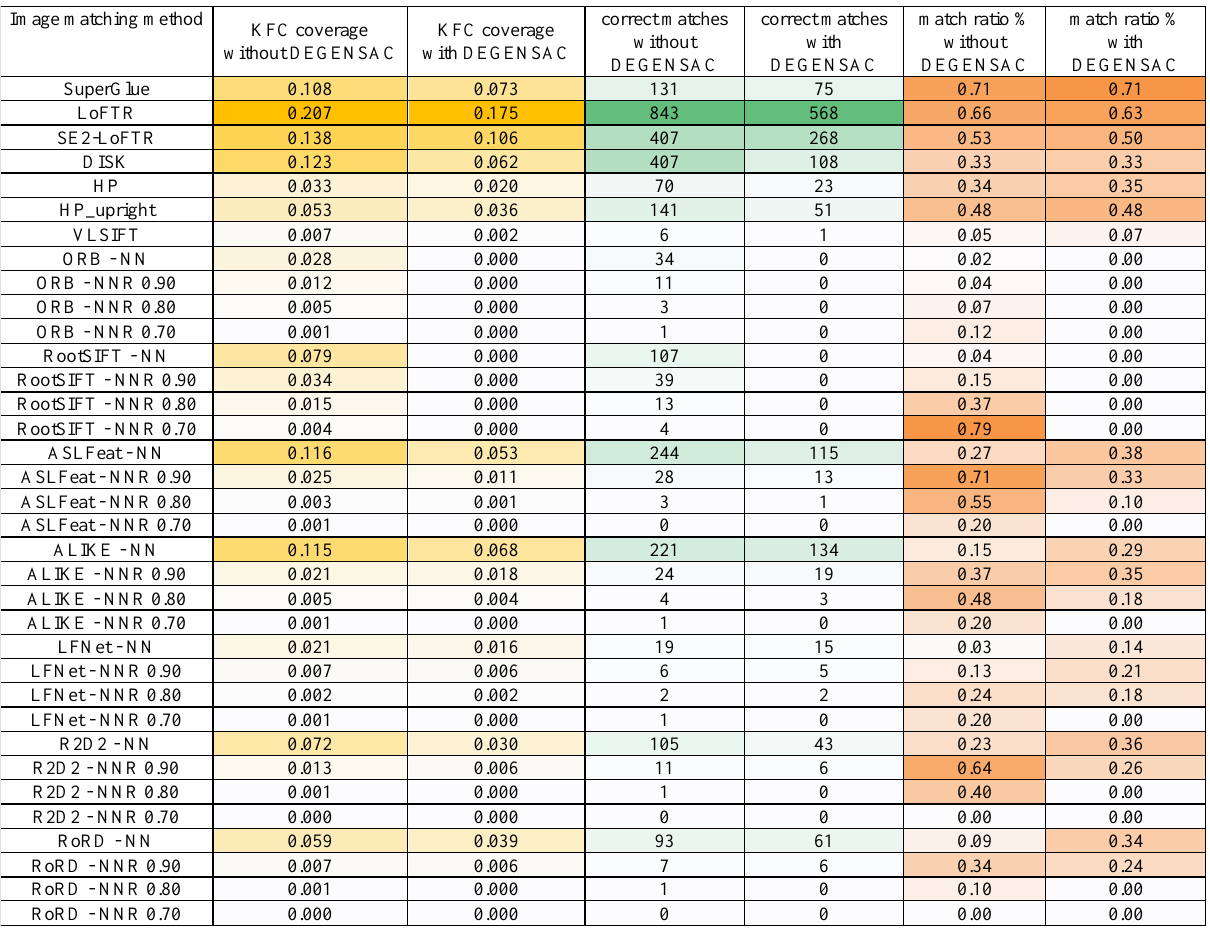
Table 1: KFC coverage, absolute correct matches and match ratio for the evaluated image matching methods. The results are averaged on the whole dataset. Increasing better results are highlighted with darker